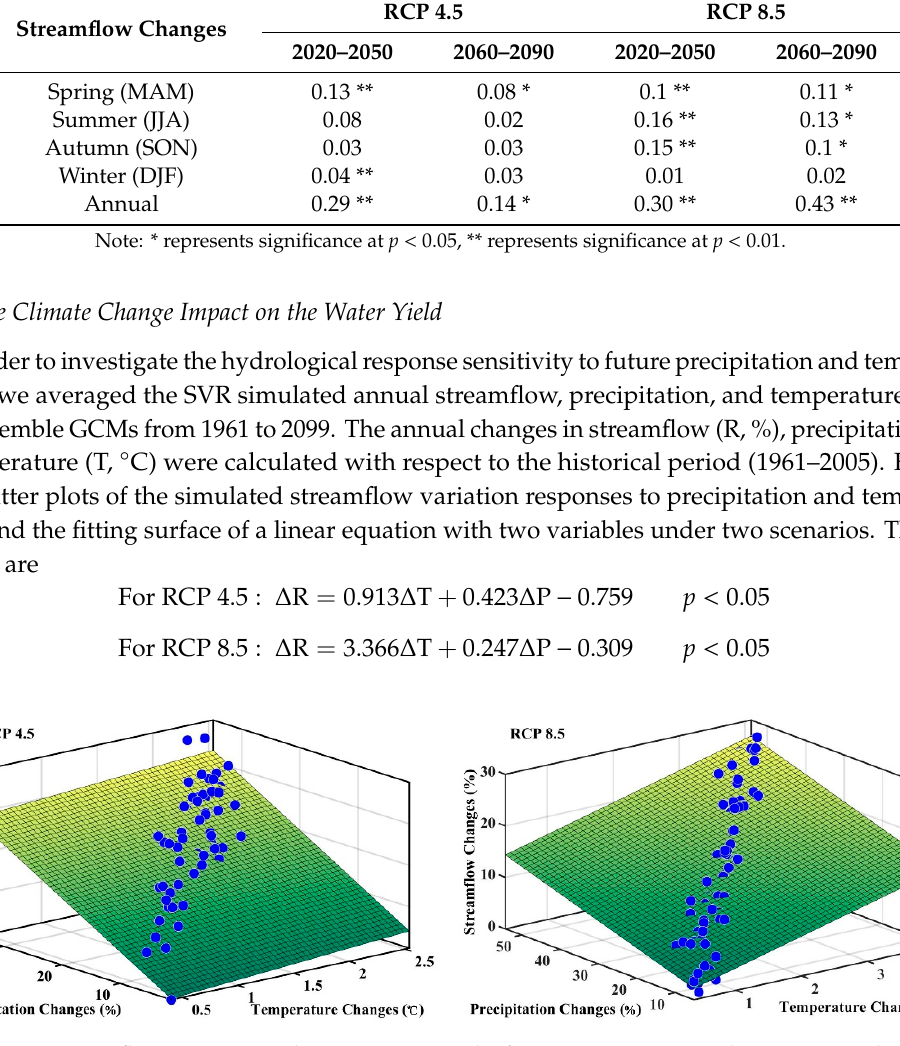
Figure 11. Streamflow variation in the experiment on the future precipitation and temperature changes under RCP scenarios 4.5 and 8.5.